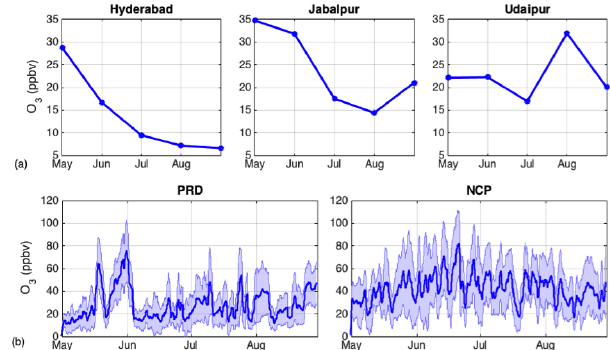
Figure 7. Ground station data during the EASM of 2011 over In- dia: Hyderabad, Jabalpur and Udaipur in panel (a) ; and over China, Pearl River Delta (PRD), and North China Plain (NCP) in panel (b) . The shaded region in panel (b) corresponds to the standard deviation of the 24-hour running average of the different stations in the PRD and NCP sites respectively. The location of the stations is plotted in Fig. 3, and more information is provided in the